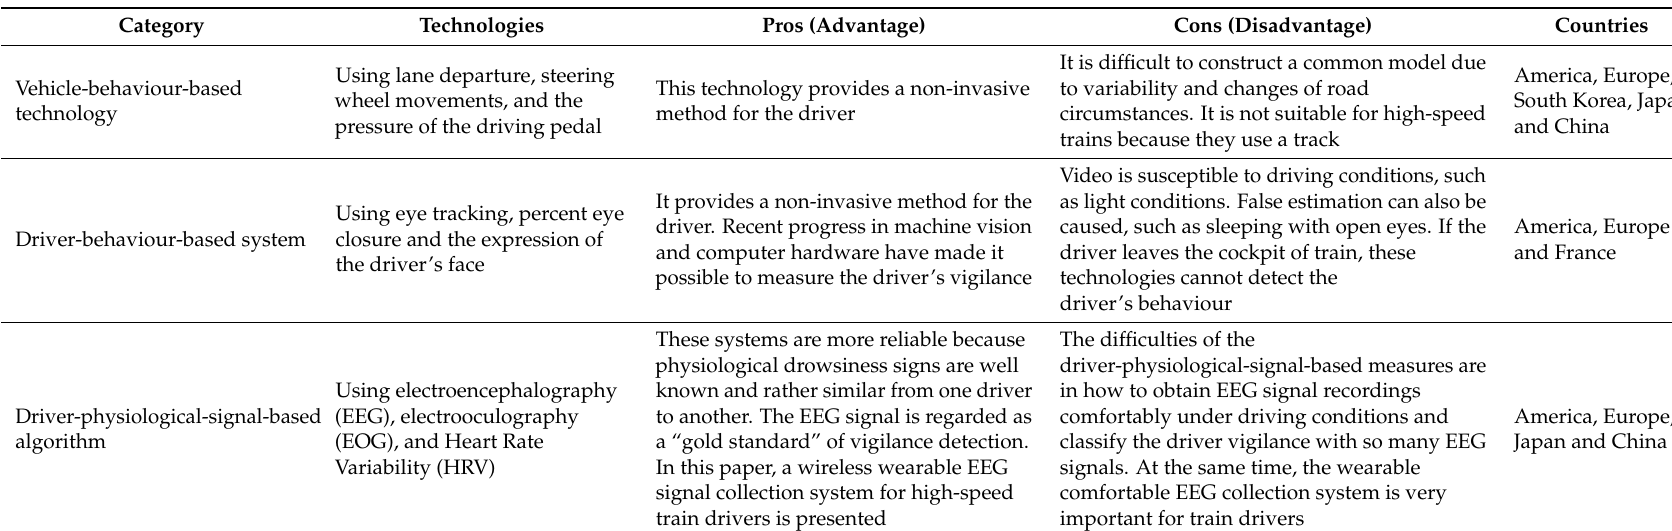
Table 4. Survey and comparison of the existing systems used for driver vigilance